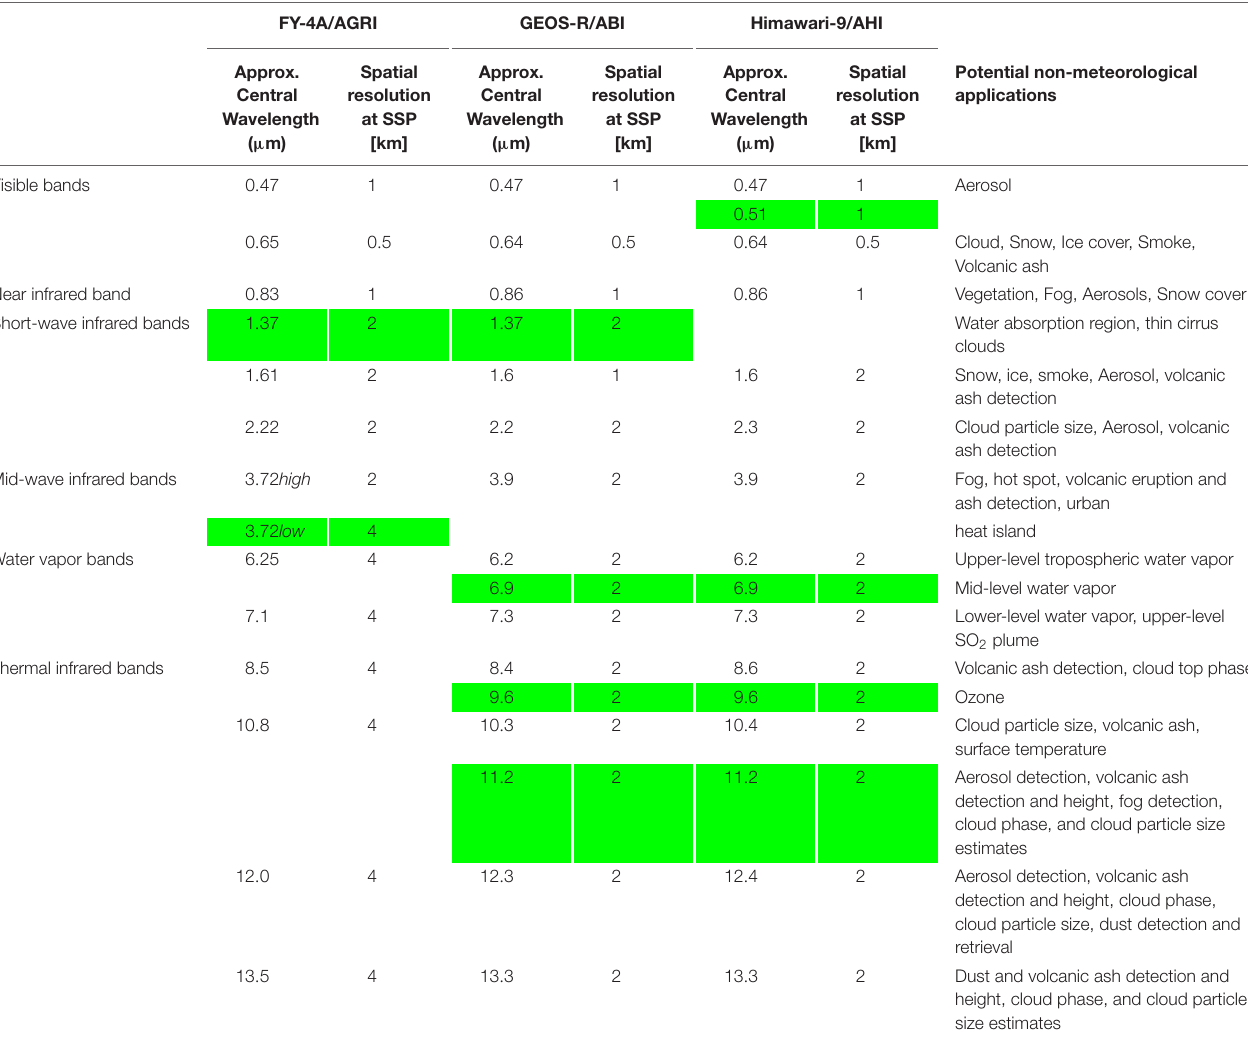
∗ Green shading indicates channels that are not present in all three